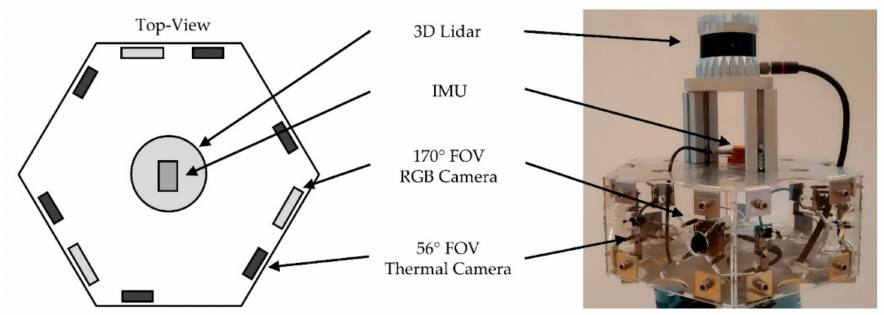
Figure 6. Workspace monitoring system in hexagon